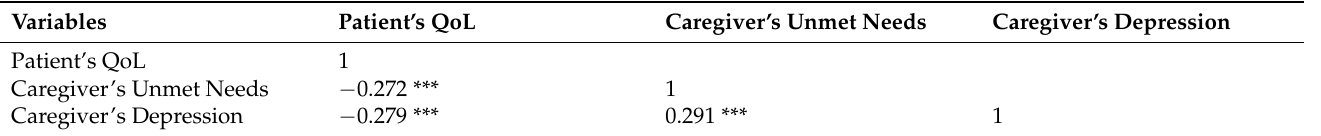
Table 3. Pearson correlations among the unmet needs and depression of caregivers and the QoL of Care recipients (N =